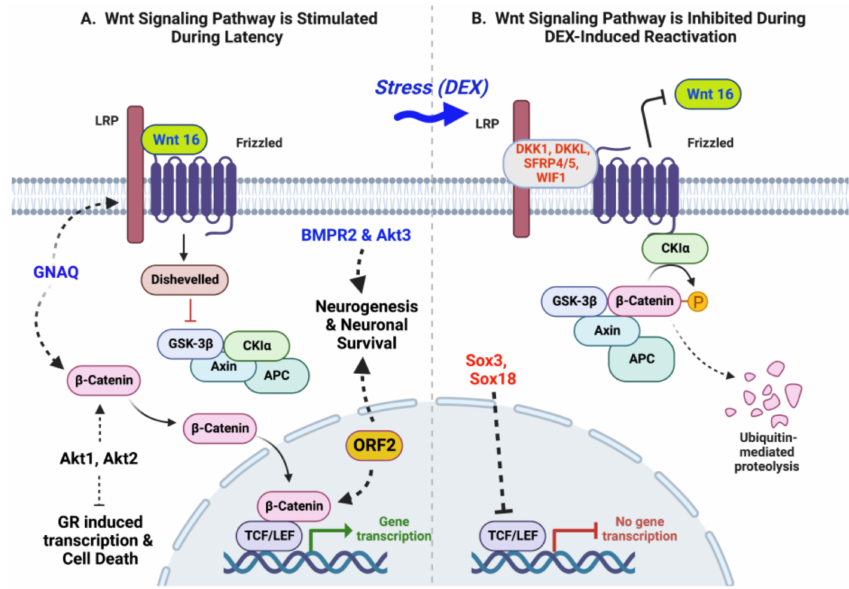
Figure 2. Summary of latency and DEX-induced reactivation on regulation of the canonical Wnt/ β -catenin signaling pathway. ( A ) Key differentially expressed cellular genes identified in TG neurons during latency are shown in blue. ( B ) Summary of how DEX inhibits the Wnt/ β -catenin signaling pathway in TG neurons, which correlates with reactivation from latency. Key cellular genes differentially expressed are shown in red. This schematic was generated using